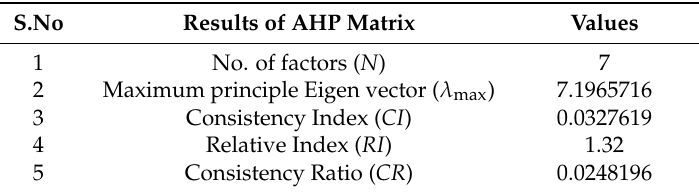
Table 5. Results from the analytic hierarchy process (AHP) matrix.